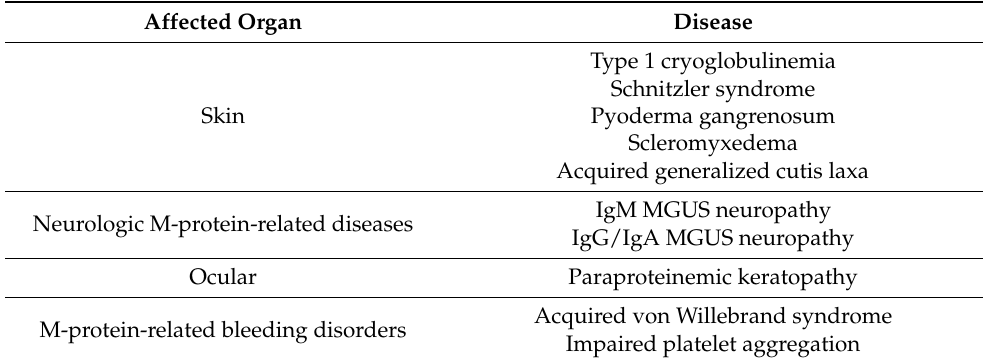
Table 1. Overview of monoclonal gammopathy of clinical significance. M-protein, monoclonal protein; MGUS, monoclonal gammopathy of undetermined